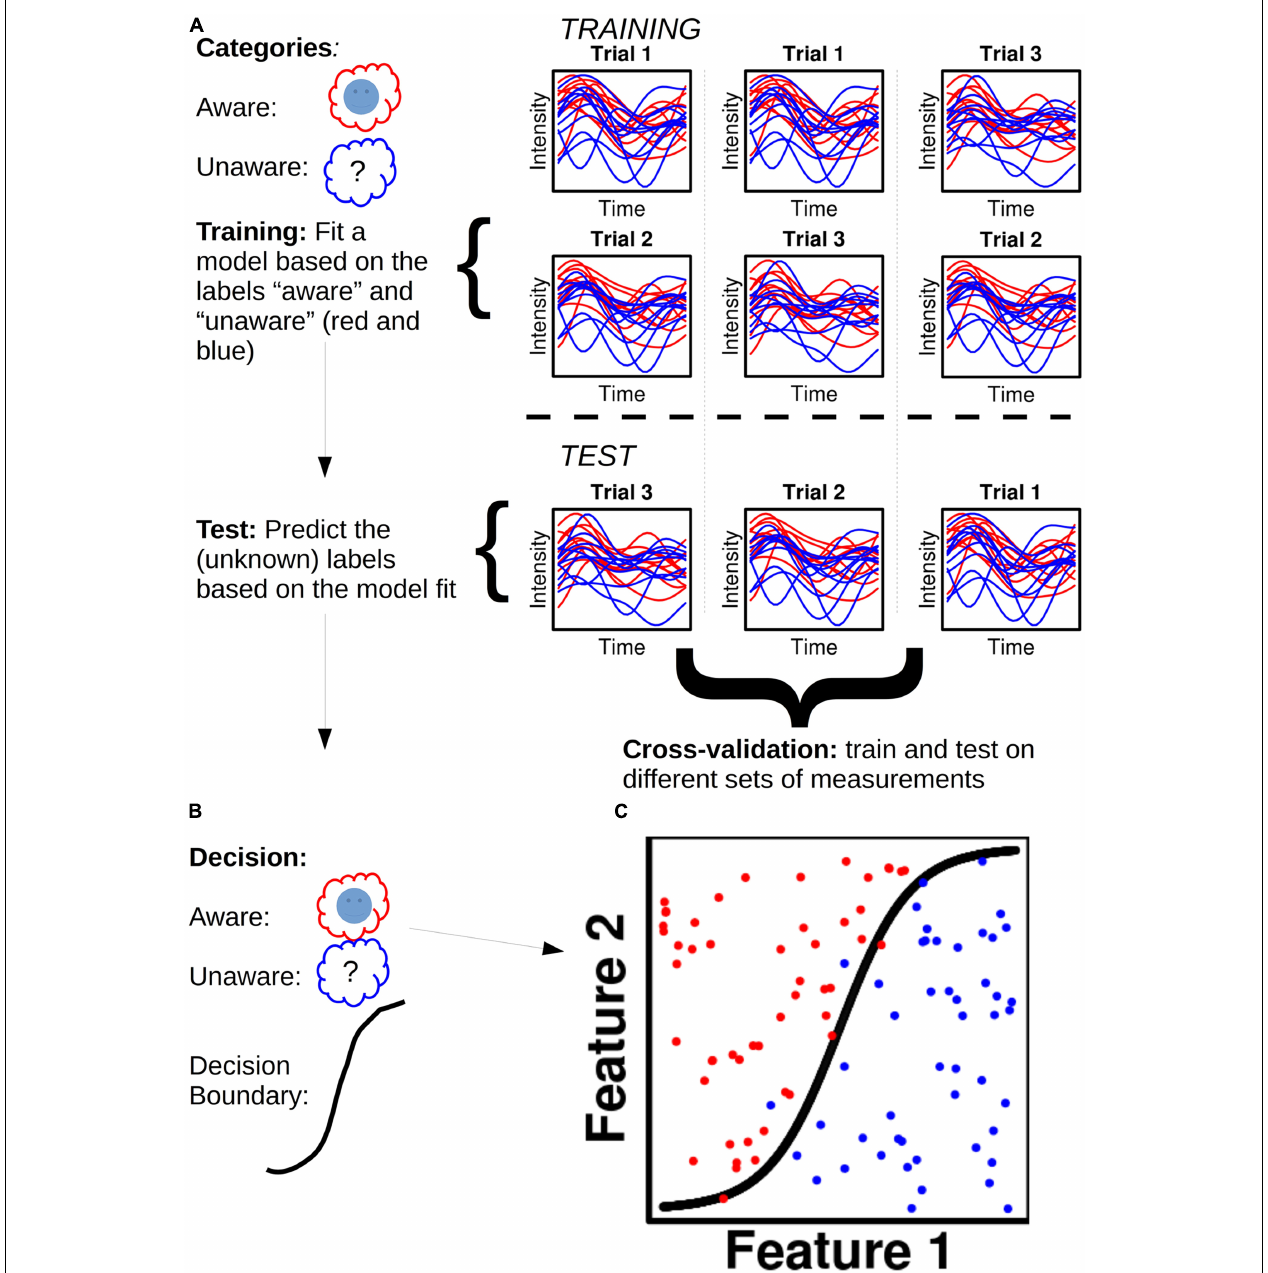
hypothetical activity developing over time courses for ten trials of aware and unaware respectively. (B) The decisions reached based on the model fit in the training set. (C) Classification is performed for 100 trials (50 aware and 50 unaware) with a non-linear decision boundary.